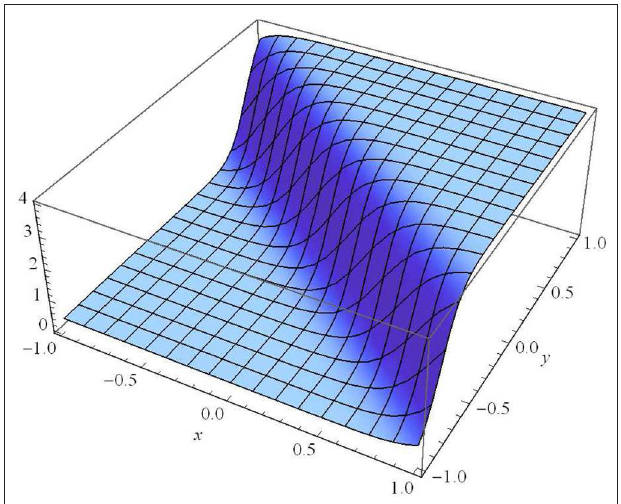
: λ III 8 ( x , y , t ) 1 = 1, λ 2 = 2, λ 3 = 3, µ 1 = 1, µ 2 = 1, µ 3 = 1, α 0 = 1, 1 | |